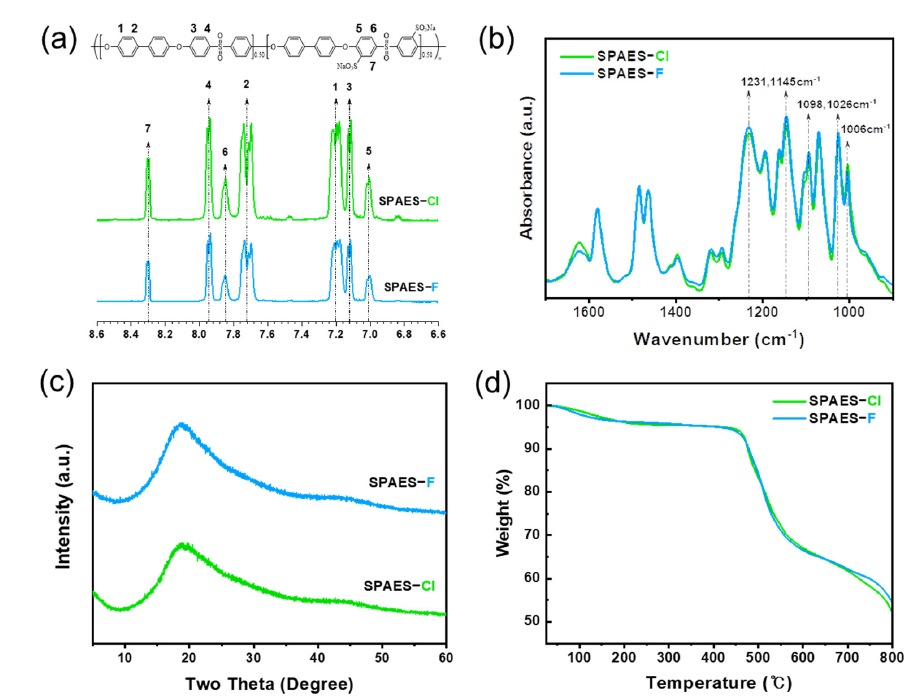
Figure 2. ( a ) 1 H NMR and ( b ) FTIR spectra, ( c ) XRD patterns, and ( d ) TGA curves of SPAES copolymers.